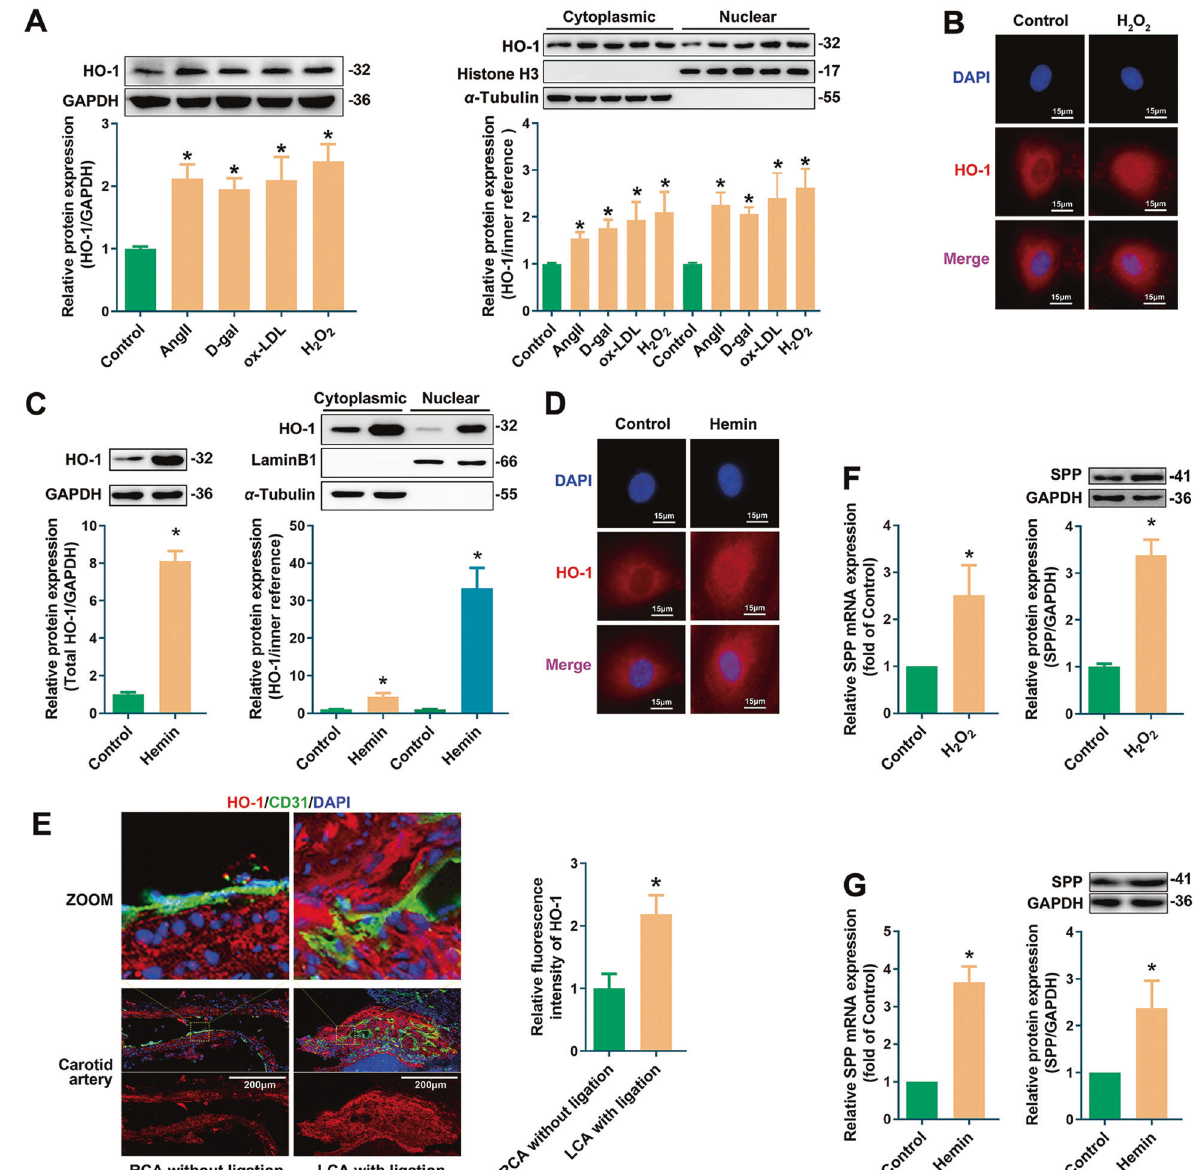
Fig. 1 Nuclear HO-1 was up-regulated in prematurely senescent endothelial cells with SPP activation. A Upregulation of total, cytoplasmic and nuclear HO-1 expression in HUVECs induced by Ang II, D-gal, ox-LDL and H 2 O 2 . * P <0.05 vs. Control. n = 5. B Immuno fl uorescence experiment showed that HO-1 was enriched in the nucleus of senescent endothelial cell induced by H 2 O 2 . n = 3. C Hemin increased the expression of total, cytoplasmic and nuclear HO-1. * P < 0.05 vs. Control. n = 5. D HO-1 accumulation occurred in the cytoplasm and nucleus induced by Hemin. n = 3. E The level of HO-1 increased in LCA with ligation, * P < 0.05 vs. RCA without ligation. n = 4. F Upregulation of SPP mRNA and protein level in HUVECs induced by H 2 O 2 . * P < 0.05 vs. Control. n = 5. G Hemin increased the mRNA and protein level of SPP. * P < 0.05 vs. Control. n =